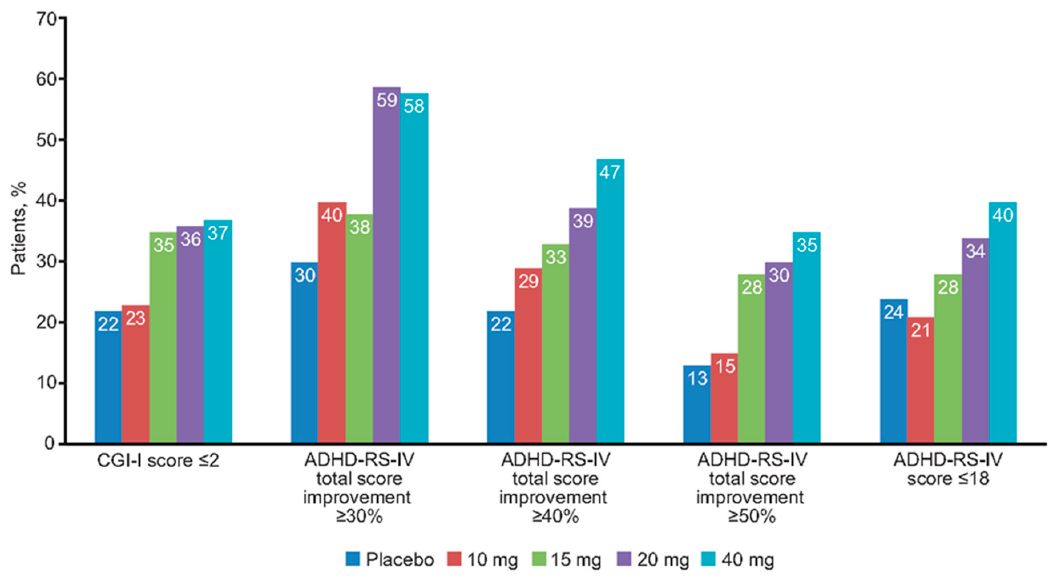
Figure 1. Percentage of patients achieving clinical response or symptomatic remission after 1 week of double-blind fixed-dose methylphenidate extended-release treatment. ADHD-RS-IV: Attention-Deficit/Hyperactivity Disorder Rating Scale, Fourth Edition; CGI-I: Clinical Global Impressions-Global Improvement.